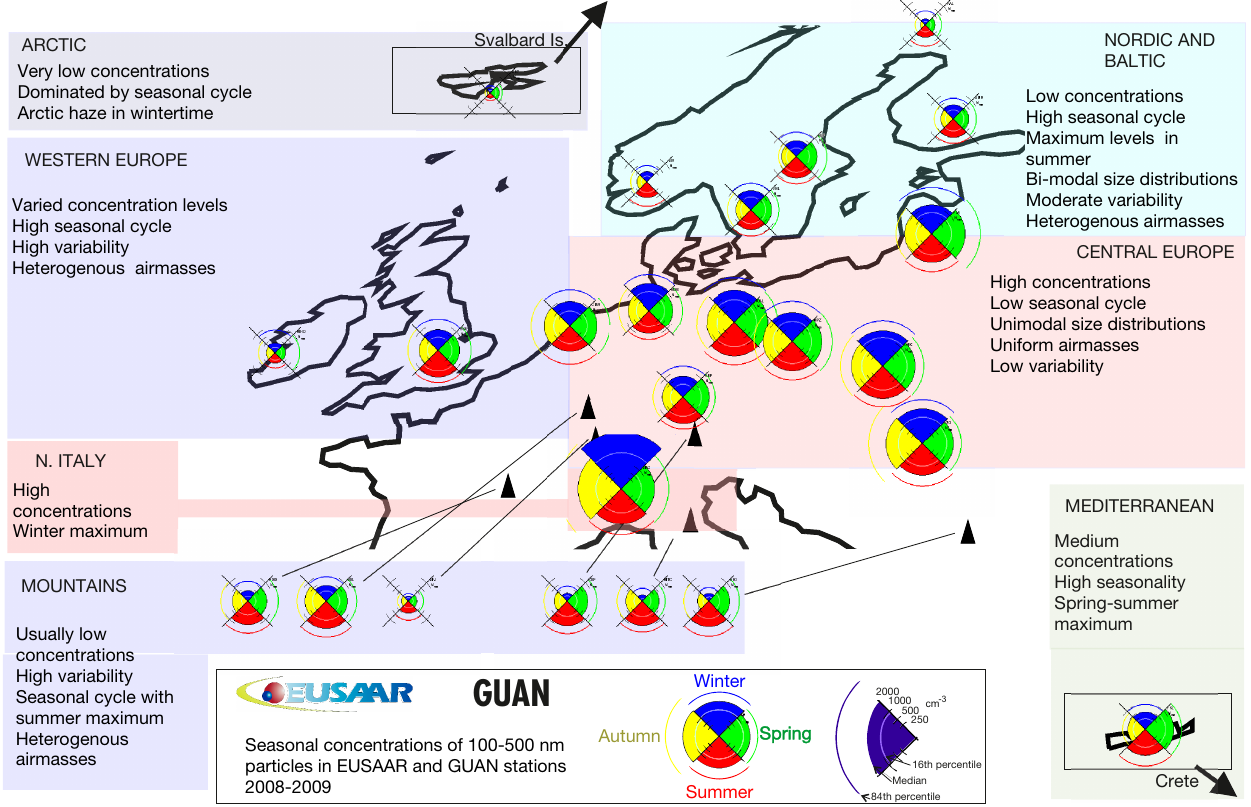
Fig. 15. Overview of EUSAAR and GUAN station measurements – spatial distribution of particle number concentrations on particle (in cm − 3 STP). The coloured areas are relative to the median concentration observed in each season, and the lower and higher arcs show 16th and 84th percentile concentrations. The colours and location of the segments show different seasons. The locations of the stations are approximate. Stations ZEP (Arctic) and FKL (Mediterranean) are located in